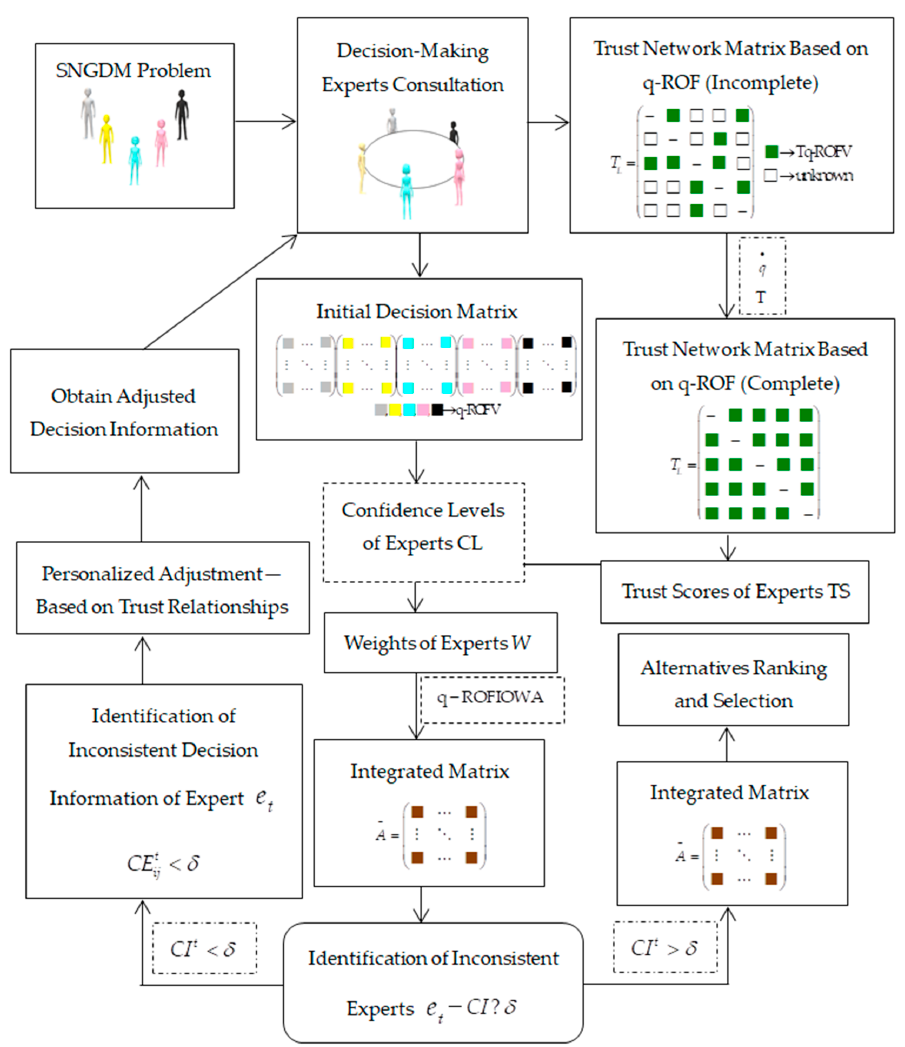
Figure 2. Framework of SNGDM method based on q-ROFS.